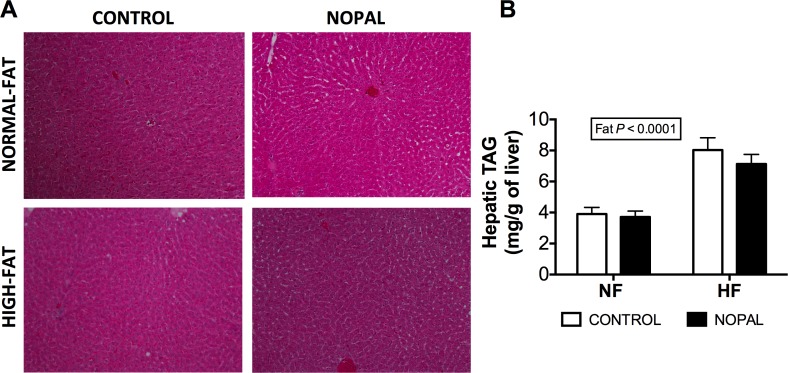
Liver histology of NF, NF + nopal, HF and HF + nopal rats.A) Representative photographs with 100x magnification of H&E stained liver sections of rats fed NF and NF + nopal or HF and HF + nopal diets. B) Hepatic triglycerides levels. Data are presented as mean ± SEM (n = 5–14 per group).